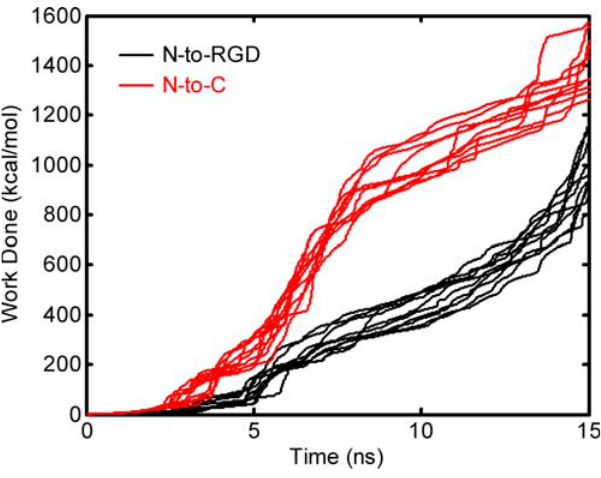
Figure 7. Calculation of the Work Needed to Partially Unfold 10FNIII Along Either Axis. Data for each of the 10 simulations pulled along N-to-RGD (black) and N-to-C (red) are shown for the first 15 ns.